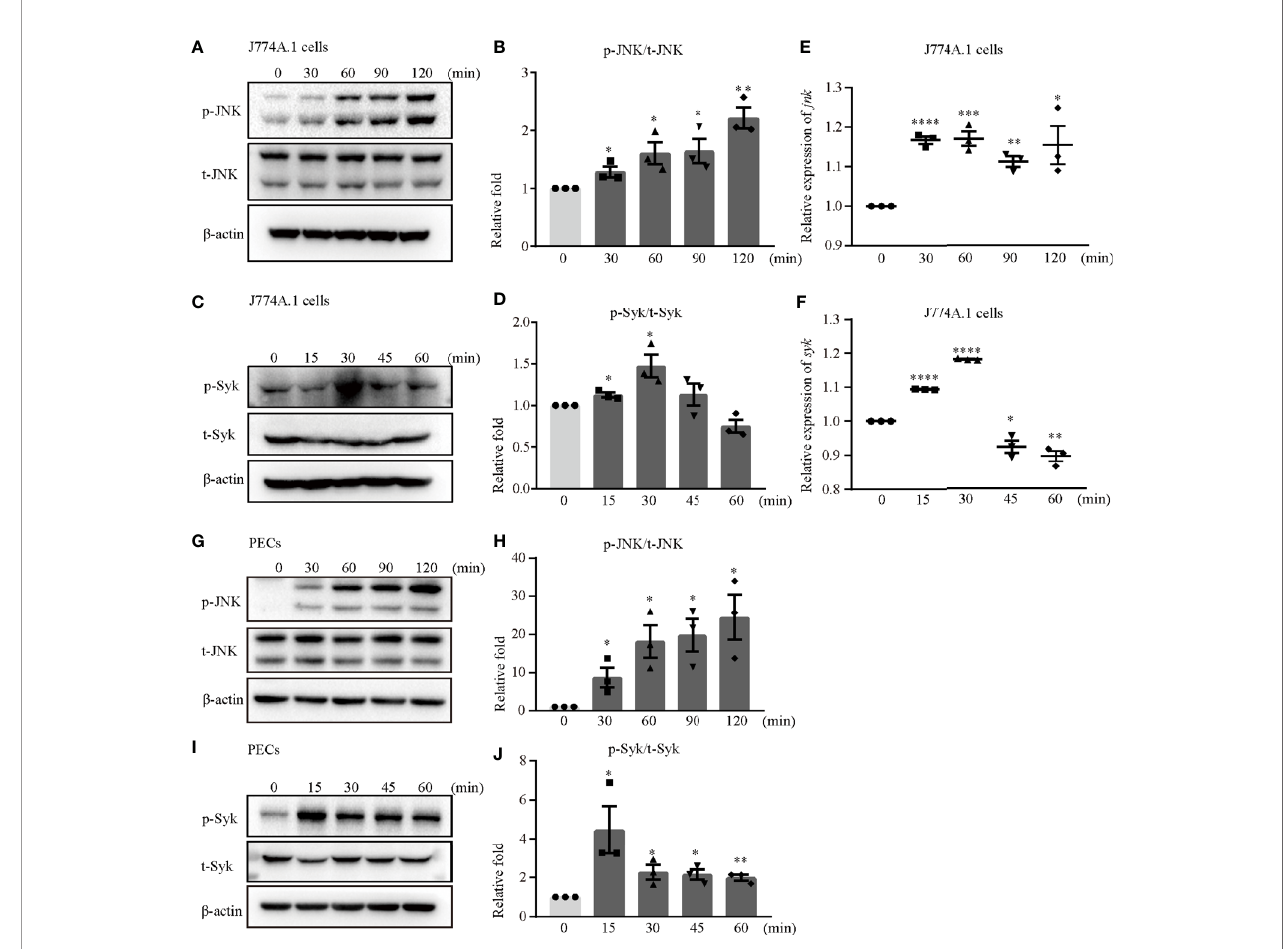
FIGURE 3 | JNK and Syk were phosphorylated upon S. aureus infection. J774A.1 cells (A – F) and PECs (G – J) were infected with S. aureus at an MOI of 5 for different time. The cell lysates and total cellular RNA were collected. (A – D) Total and phosphorylation levels of JNK (A) and Syk (C) were detected by western blot. p-JNK/t-JNK (B) and p-Syk/t-Syk (D) were analyzed by relative densitometric quanti fi cation. (E, F) The mRNA expression levels of jnk (E) and syk (F) were quanti fi ed by RT-PCR. (G – J) The protein levels of t-JNK, p-JNK (G) and t-Syk, p-Syk (I) were detected by western blot. p-JNK/t-JNK (H) and p-Syk/t-Syk (J) were analyzed by relative densitometric quanti fi cation. Similar results were obtained in three independent experiments in data. Data shown are means ± SEMs; * P < 0.05, ** P < 0.01, *** P < 0.001, **** P < 0.0001 vs . non-infection